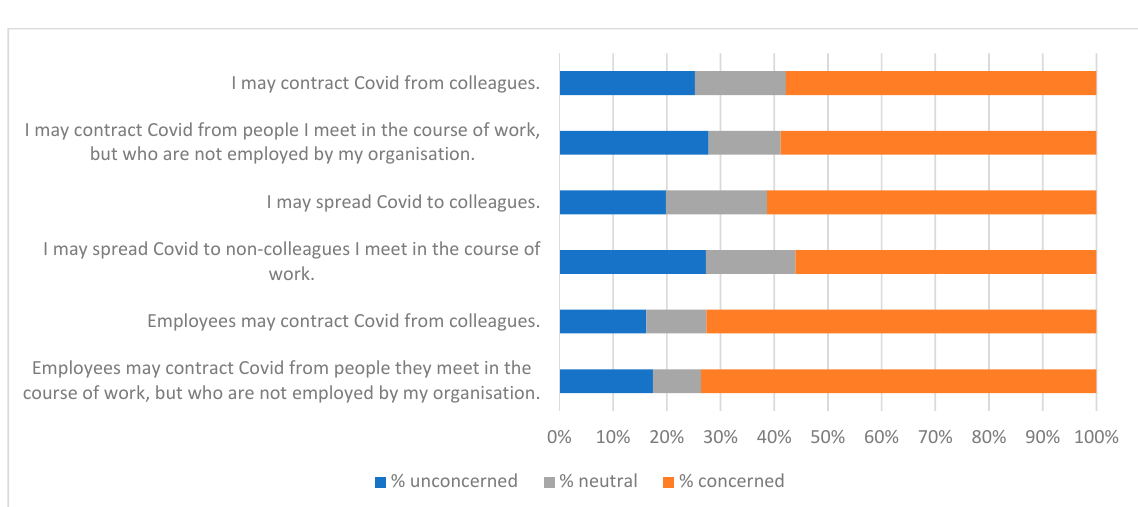
Figure 4. Impact of COVID-19.